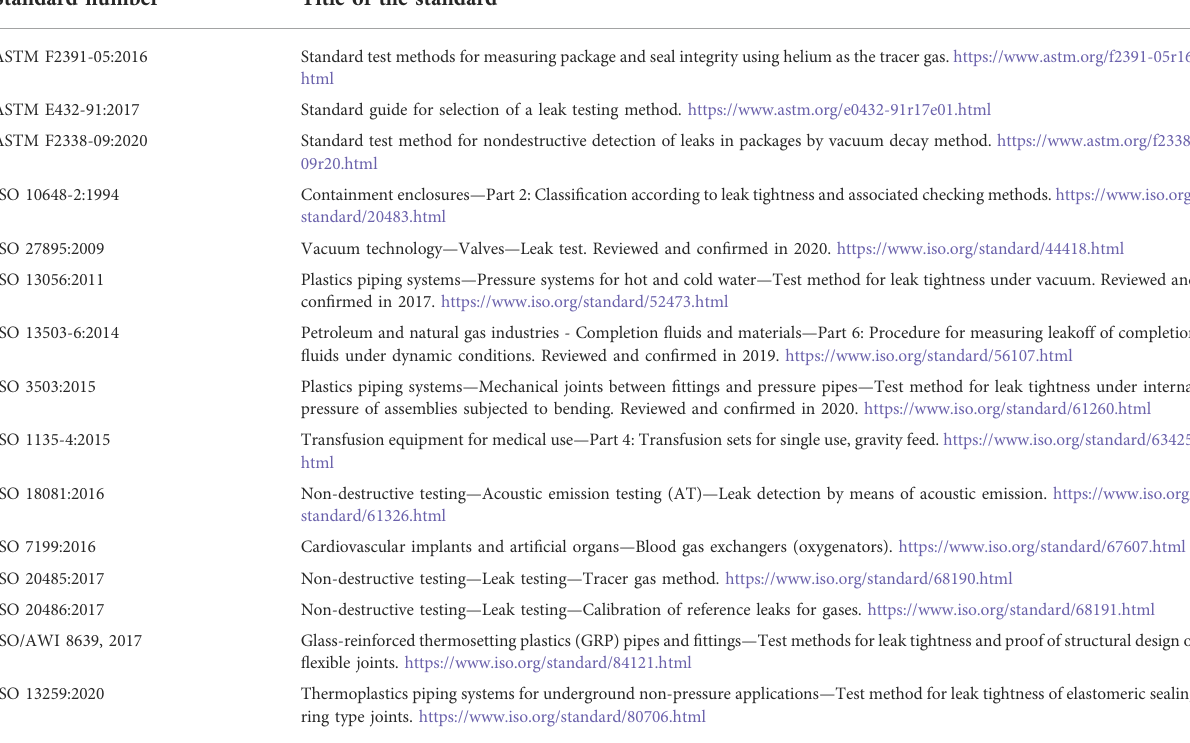
TABLE 1 Examples of existing standards from ASTM International and International Organization for Standardization (ISO) that contain aspects of leakage testing. Standard